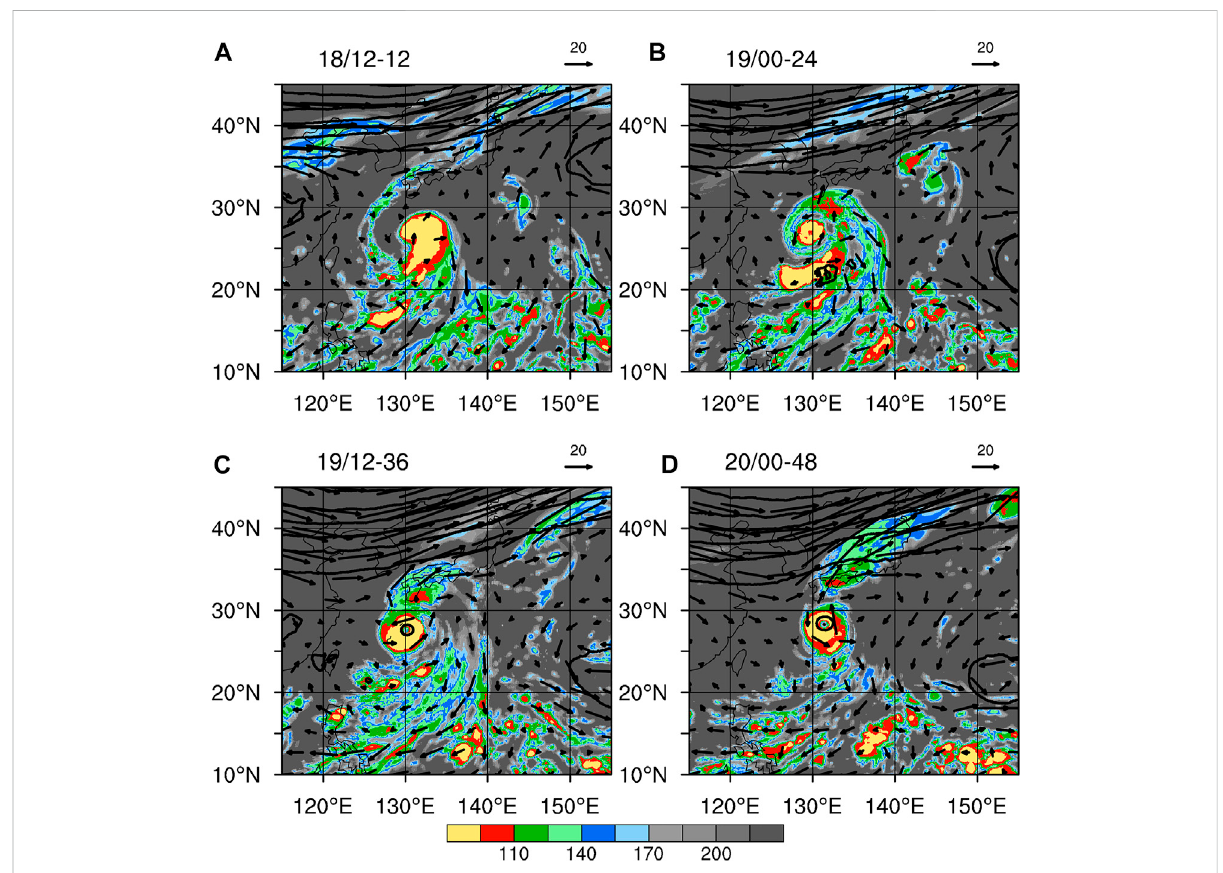
FIGURE 4 The fl ow (vectors, m s − 1 ), geopotential height (contours, gpm) at 200 hPa and outgoing long-wave radiation (shaded areas, W m − 2 ) for (A) 12-h integration (1200 UTC 18 September), (B) 24-h integration (0000 UTC 19 September), (C) 36-h integration (1200 UTC 19 September) and (D) 48-h integration (0000 UTC 20